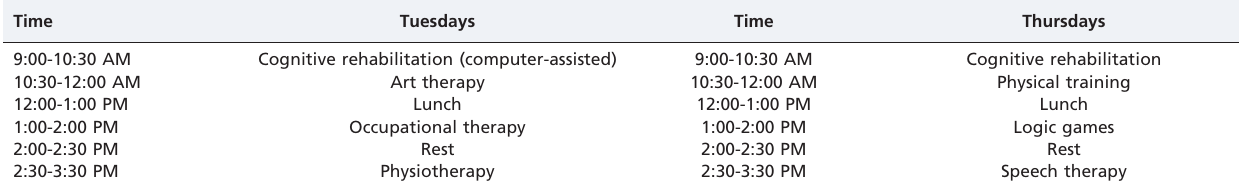
Table 1 - Schedule of activities (experimental